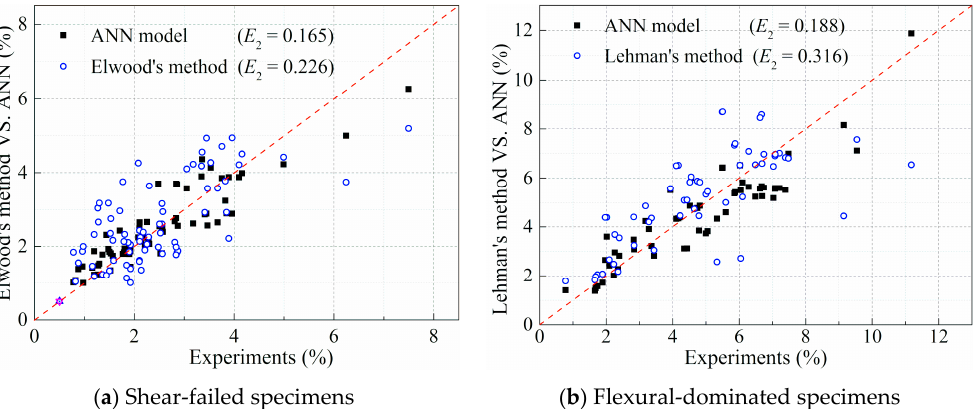
( b ) Test and validation set Figure 10. Comparison of experimental results of the capping drift and predicted results from the ANN model. Similarly, Figure 11 shows a comparison of the yielding drift of column between experimental results and predicted results from the ANN model. The mean absolute error for the training set and the test-validation set is 0.1081 and 0.0752, and the corresponding goodness of fit is 0.8548 and 0.8638, respectively. Generally, the yielding drift of RC columns always appears earlier with low nonlinearity than the ultimate drift. Therefore, the proposed ANN-based model can get a better prediction on the yielding drifts than the ultimate drift due to the nonlinearity difference between these two physical parameters.